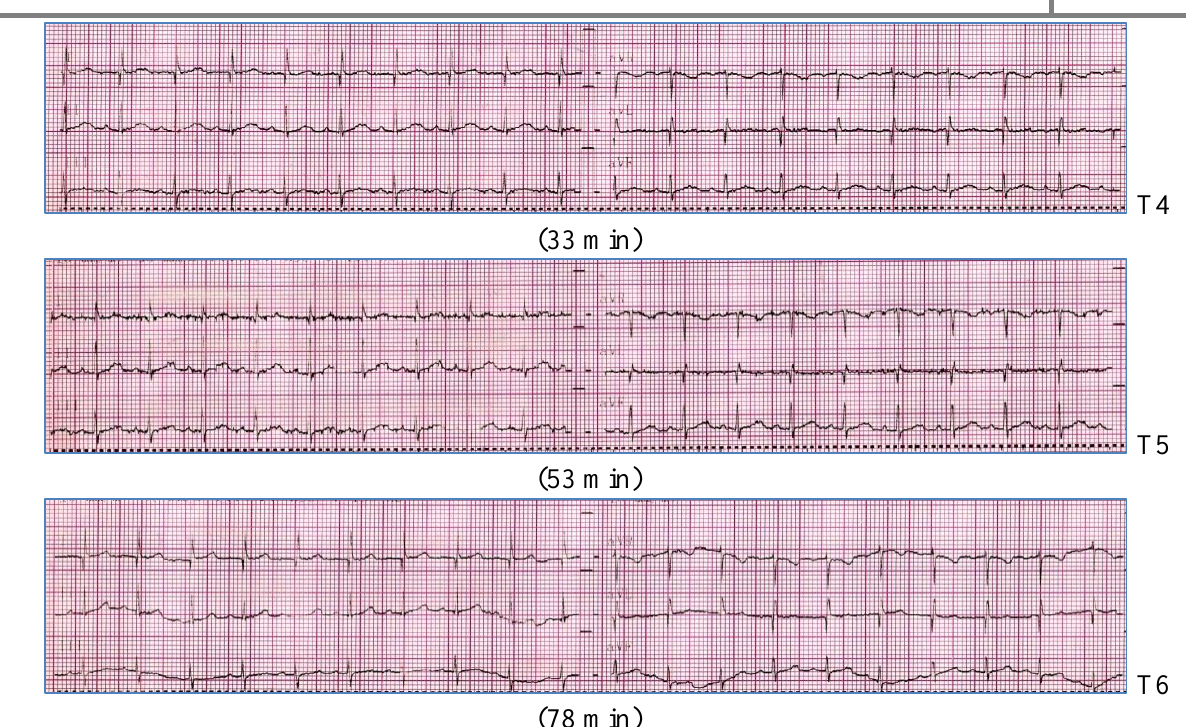
Figure, 1: Electrocardiography results of anesthetic protocol, for local male rabbit in different times (T): T1 (control), T2 (11 min), T3 (26 min), T4 (33 min), T5 (53 min) and T6 (78 min) at the end of